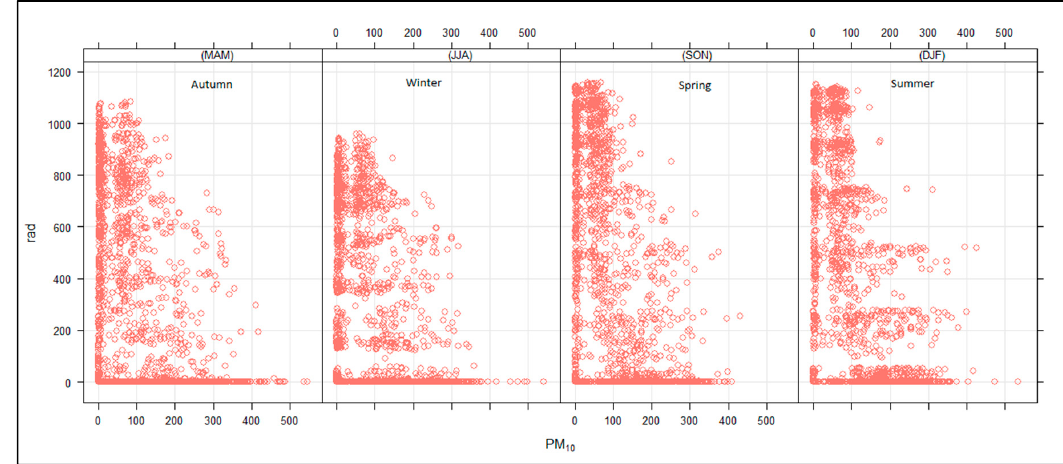
Figure 13. Relationship between PM 10 ( µ g.cm − 3 ) and solar radiation (KWh / m 2 ) for autumn, winter, spring and summer. PM Seasonl Varaiation The average PM 10 concentrations for the different seasons showed maximum values of 15.2 µg.m − 3 (autumn), 27.3 µg.m − 3 (winter), 24 µg.m − 3 (spring), and 25.3 µg.m − 3 (summer). These results